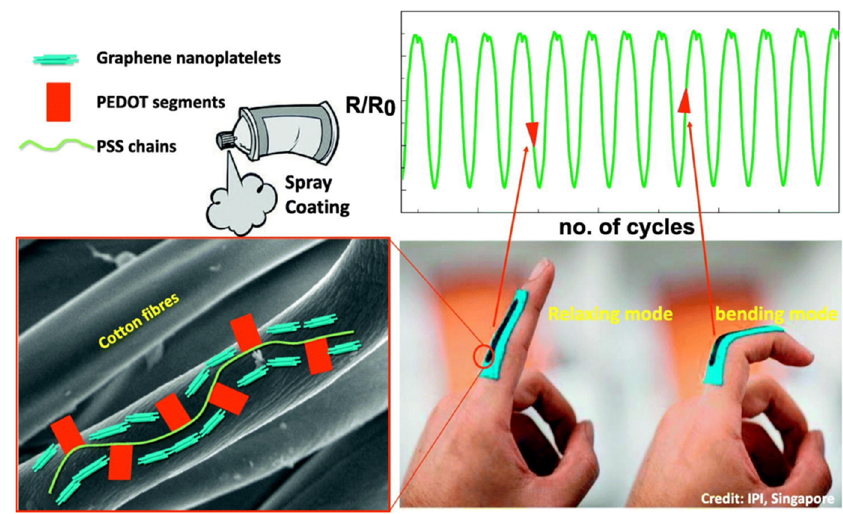
Figure 12. Representation of the cotton fabrics of PEDOT:PSS/G with strain response. Reprinted with permission from reference [183], Copyright Elsevier (2017).